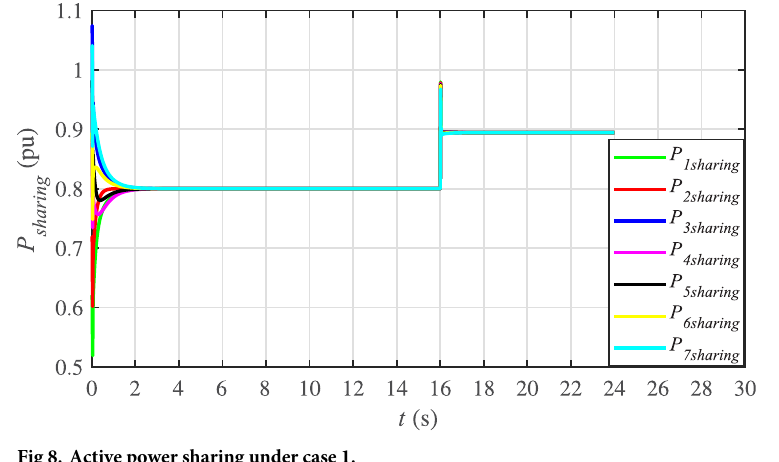
Fig 8. Active power sharing under case 1.